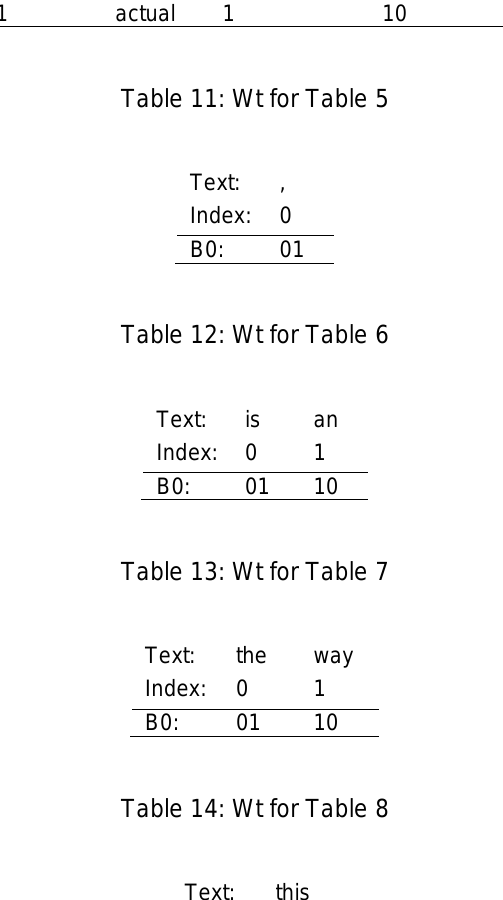
Table 7: Word-frequency table for length three